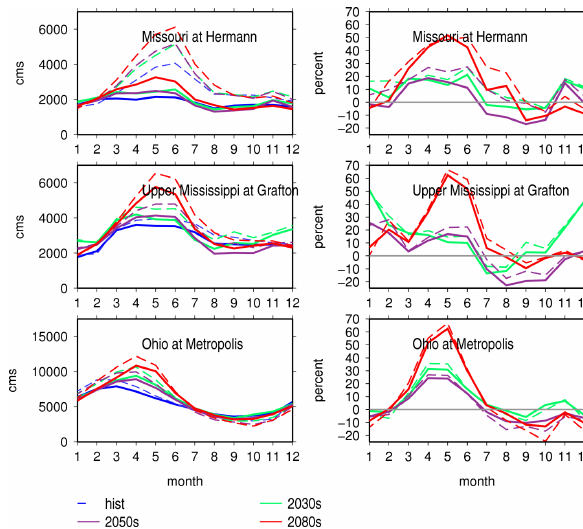
Figure 11: Left column: Simulated mean monthly natural (dashed) and regulated (solid) flow at Hermann, Grafton and 2 Metropolis for different time period: historical (98-99), 2030s B1(2015-45), 2050s B1(2035-2065) and 2080s B1(2065- 3 Fig. 10. Left column: simulated mean monthly natural (dashed) and 2095).Right column: relative change in mea mean monthly flow of natural (dashed) and regulated (solid) flow for future 4 B1 periods with respect to their historical counterparts. Close monthly relative changes between natural and regulated 5 regulated (solid) flow at Hermann, Grafton and Metropolis for dif- flow with the A2 emission scenario were also observed. 6 ferent time periods: historical (1998–1999), 2030s B1 (2015–2045), 2050s B1 (2035–2065) and 2080s B1 (2065–2095). Right column: relative change in mean monthly flow of natural (dashed) and regu- lated (solid) flow for future B1 periods with respect to their histori- cal counterparts. Results with A2 emission scenario were